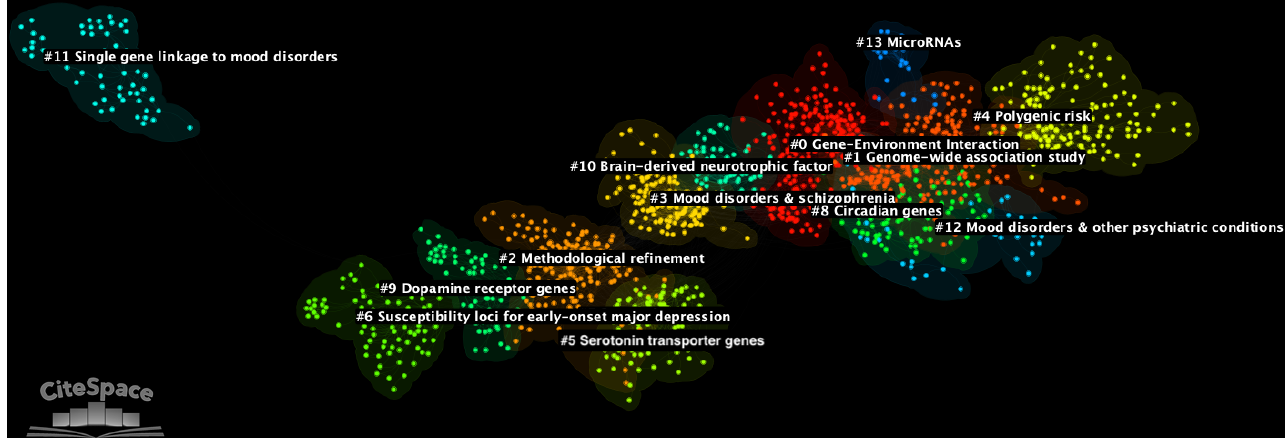
Figure 2. Document co-citation analysis network of all literature on the genetics of mood disorders with 13 generated clusters. The earliest thematic clusters appear on the left of the figure, while more recent clusters are displayed on the right. In the network, single nodes represent individual documents. The image was generated with the CiteSpace software